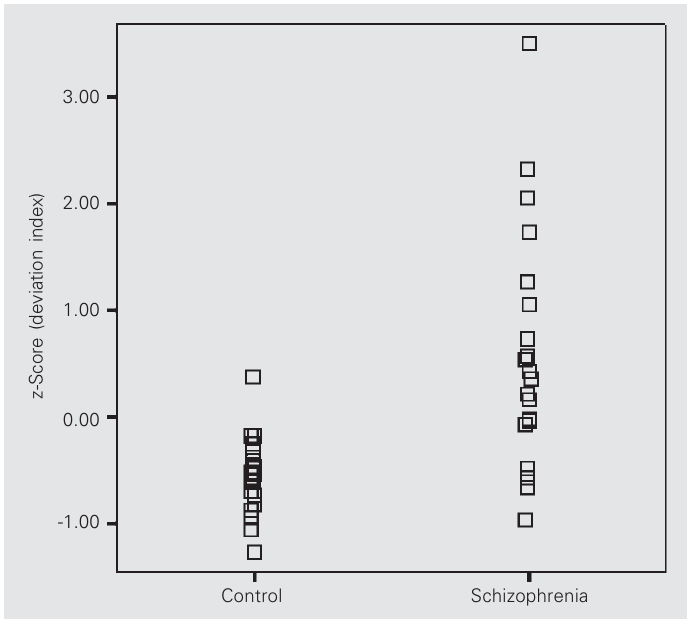
Figure 4. Electrode positions where statistically significant differ- ences in mean voltage between patients and controls were observed (P < 0.01, MANOVA). The fronto-central set was cen- tered at the left of FCz and the frontotemporal set at FT8. Elec- trodes were plotted on the original control group average map to show relation with regions of high slow potential